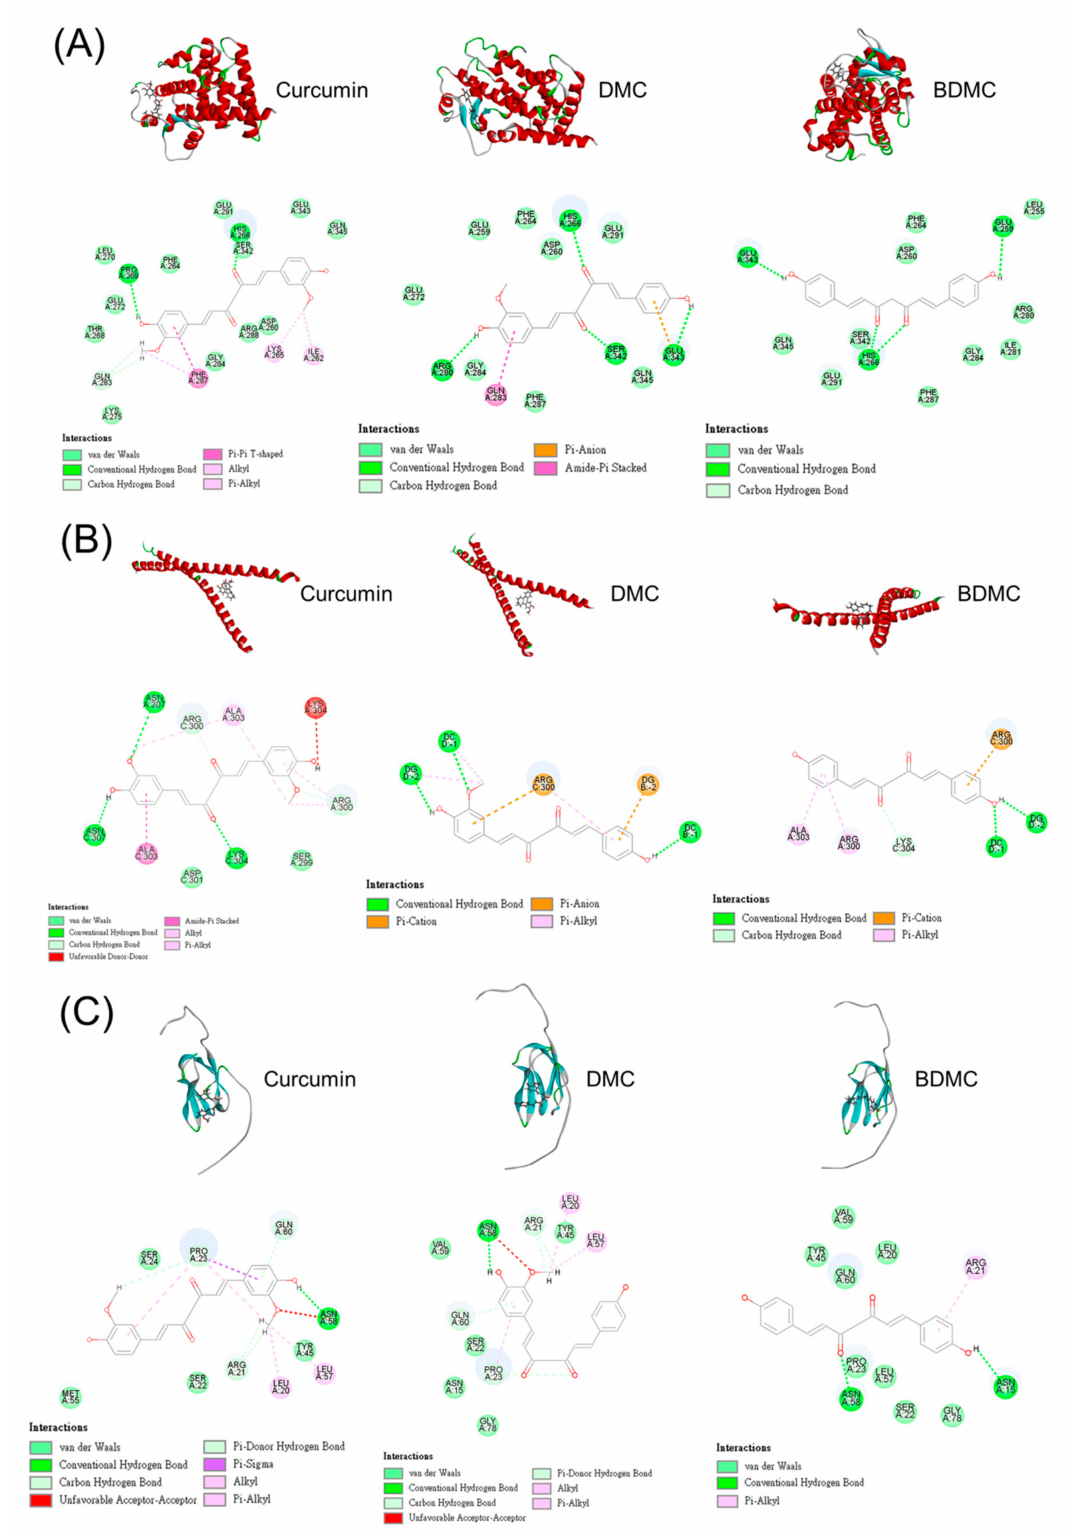
Figure 7. The docking poses of curcuminoids at the adipogenic or lipogenic factors. ( A ) The docking poses and the interaction of curcuminoids at PPAR γ ; ( B ) the docking poses and the interaction of curcuminoids at C/EBP α ; and ( C ) the docking poses and the interaction of curcuminoids at